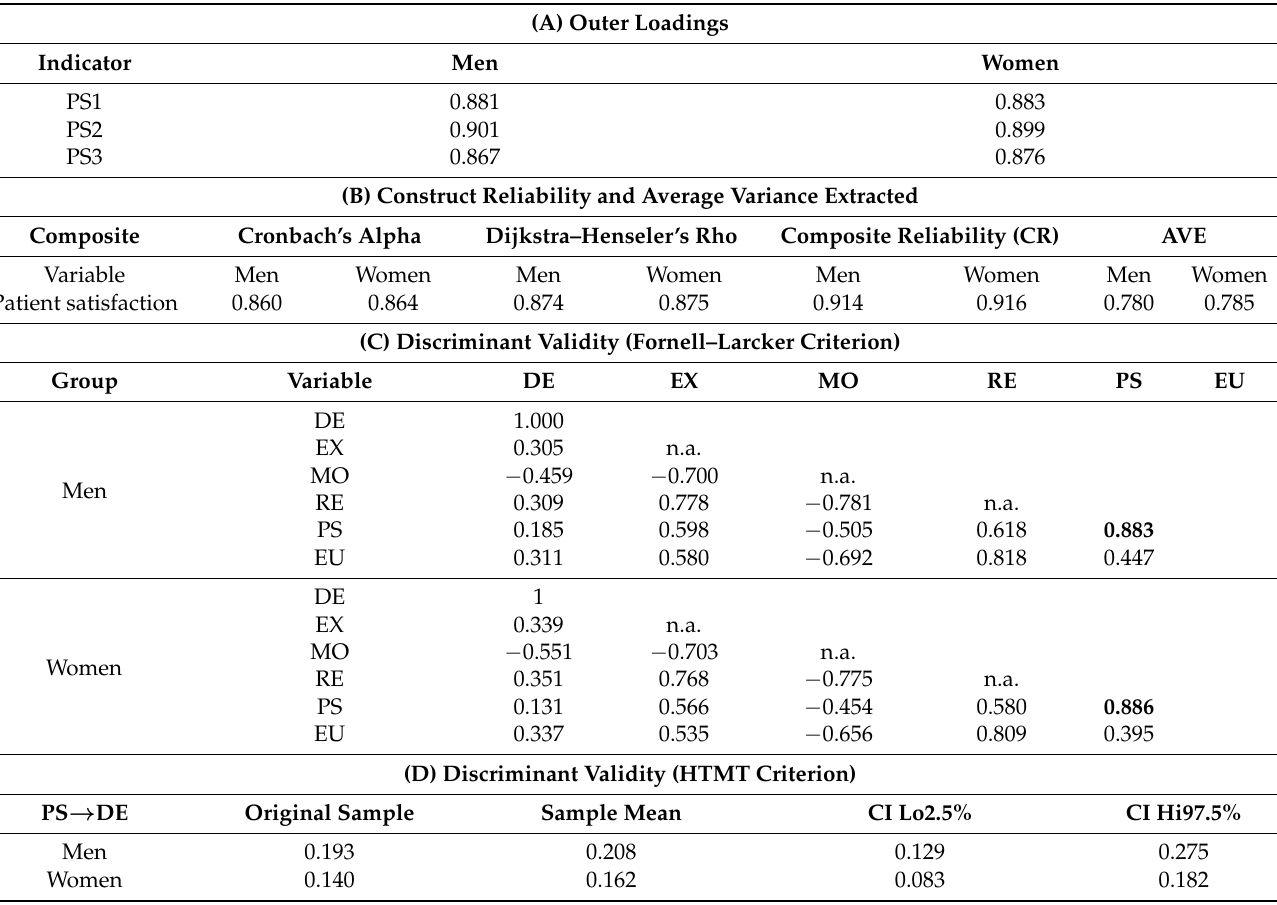
Table 3. Assessment of measurement model. Estimated constructs in mode